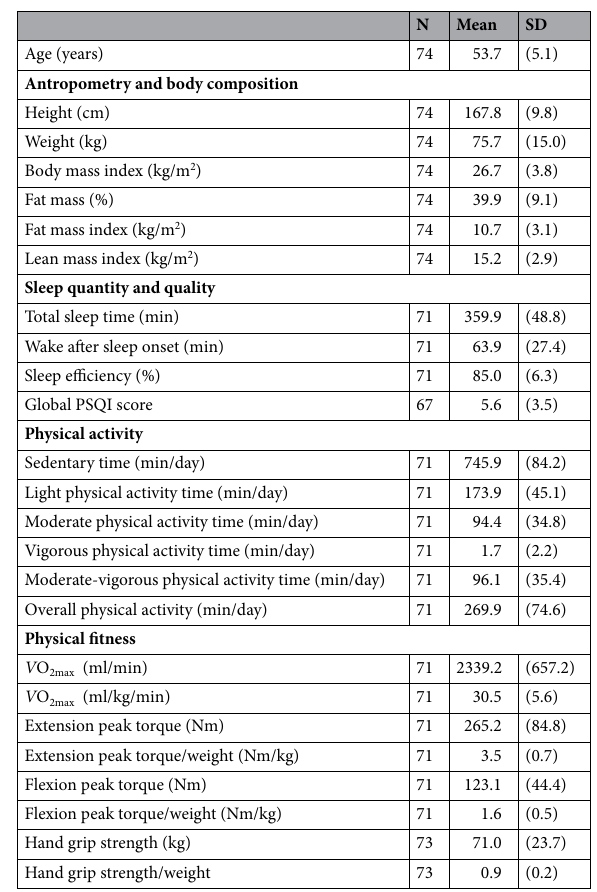
Table 1. Descriptive characteristics of participants. SD standard deviation, PSQI Pittsburgh Sleep Quality